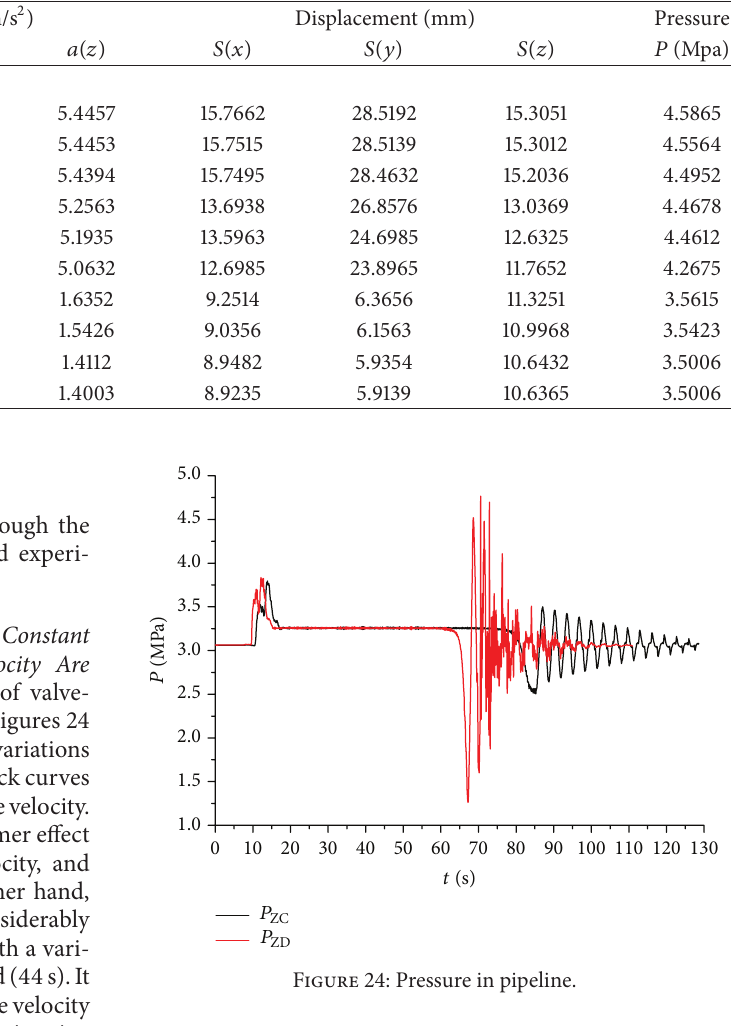
Figure 23: Composition of HCVs control system. Table 3: Measured values of water hammer parameters.